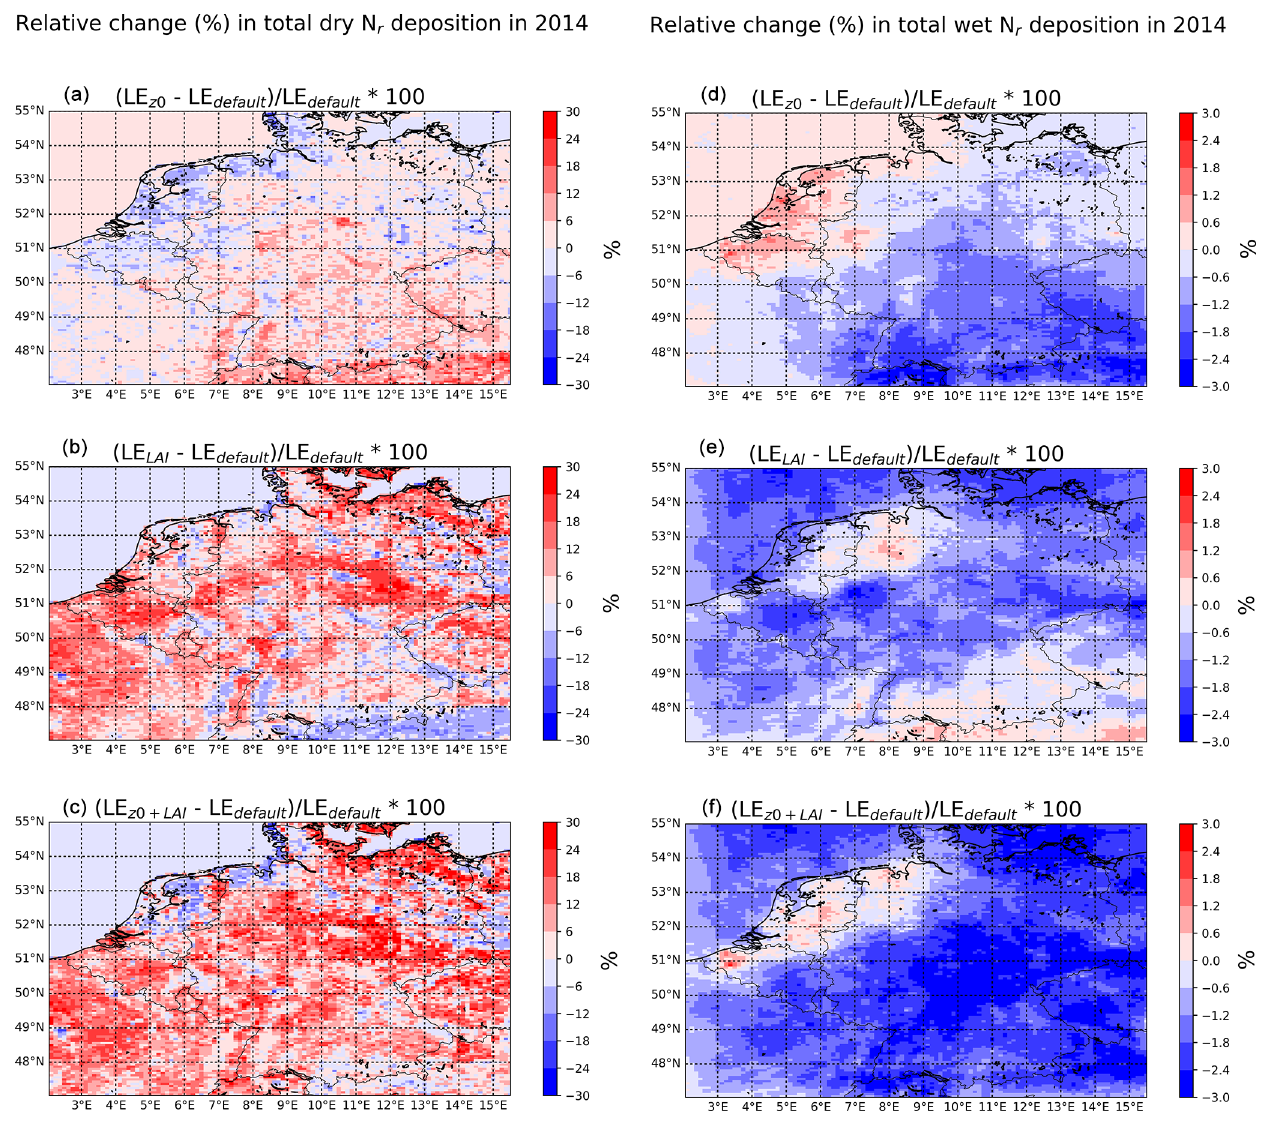
Figure 11. The relative change in total dry (a, b, c) and wet (d, e, f) N r deposition in 2014 for the different model runs relative to the default LOTOS-EUROS run. The first row indicates the changes related to the implementation of the updated z 0 values. The second row indicates the changes related to the implementation of the MODIS LAI values. The third row shows the combined effect of both these updates. (Please note the different